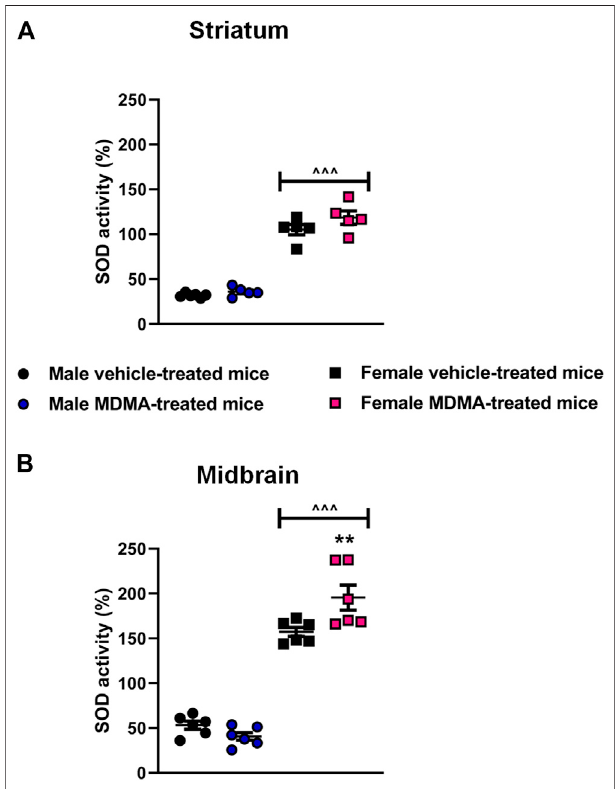
FIGURE3| EffectsoftreatmentwithMDMAontheactivityofsuperoxide dismutase (SOD) in the striatum (A) and midbrain (B) . Adult male and female mice were treated with either MDMA (4 × 20 mg/kg, i. p. 2 h apart) or vehicle (saline solution, i. p.). N (cid:2) 5 – 6 mice per group. Values are reported as mean ± S.E.M. ** p < 0.01 compared with the respective group of vehicle- treatedmice; ∧∧∧ p < 0.001comparedwiththerespectivegroupsofmalemice, by Newman-Keuls post-hoc